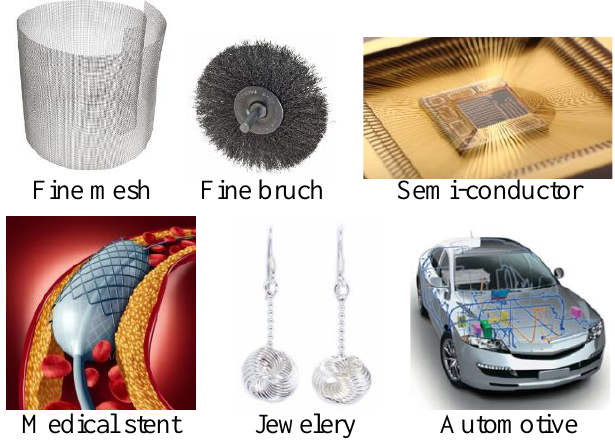
Figure 1. Representative applications of very fine wire.